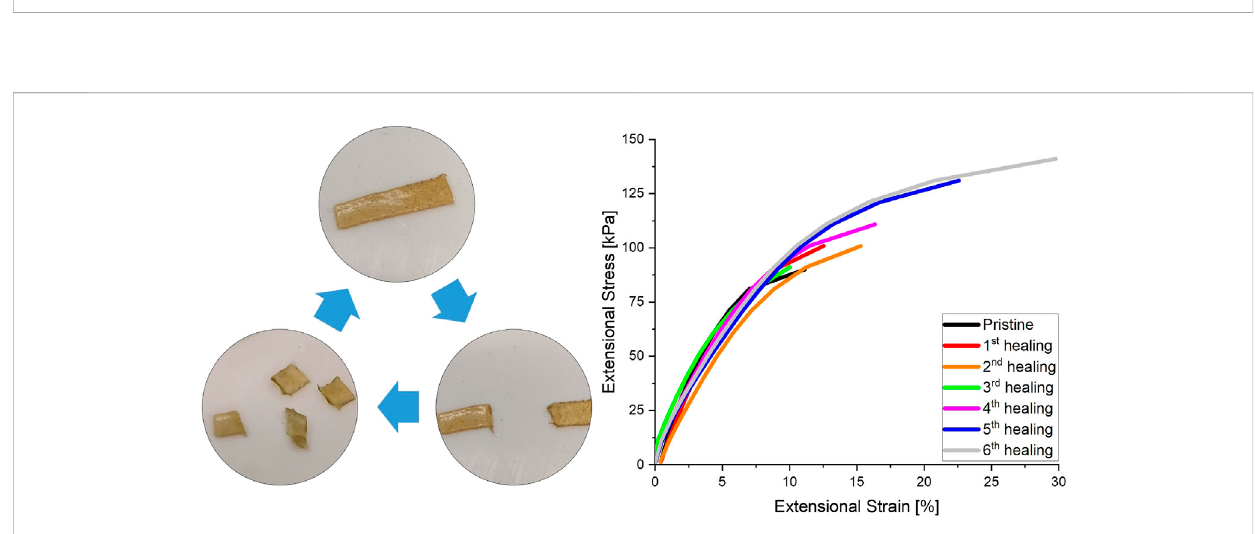
FIGURE 5 Healing cycles performed by extensional DMA testing. Reprocessing was done by hot-pressing for 1 h at 80 ° C in a Te fl on mould (10 × 5 × 1 mm). DMA was performed by linearly increasing the extensional stress till material breakage. After breakage the sample was cut into small pieces before